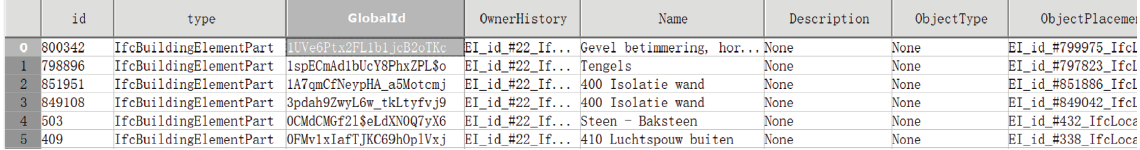
Figure 2: An exemplary dataset for type IfcBuildingElementPart of IFC in HDFViewer 3.1.0 as a demonstration of data simplicity in HDF.